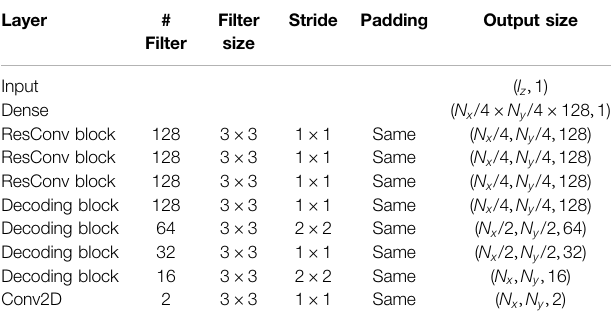
TABLE 2 | Decoder architecture.